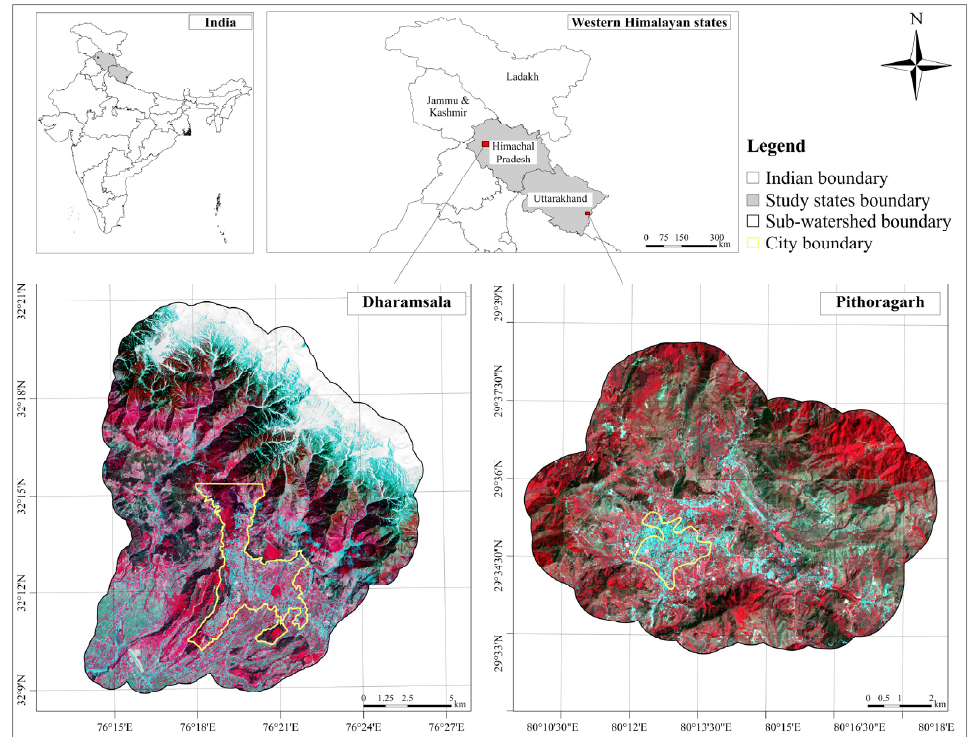
Figure 1. Geographic locations of the study sites which fall in two Indian Western Himalayan states: Himachal Pradesh and Uttarakhand (Row 1); satellite image of each study site at the sub-watershed boundary overlaid by the city administrative boundary (yellow color) (Row 2).